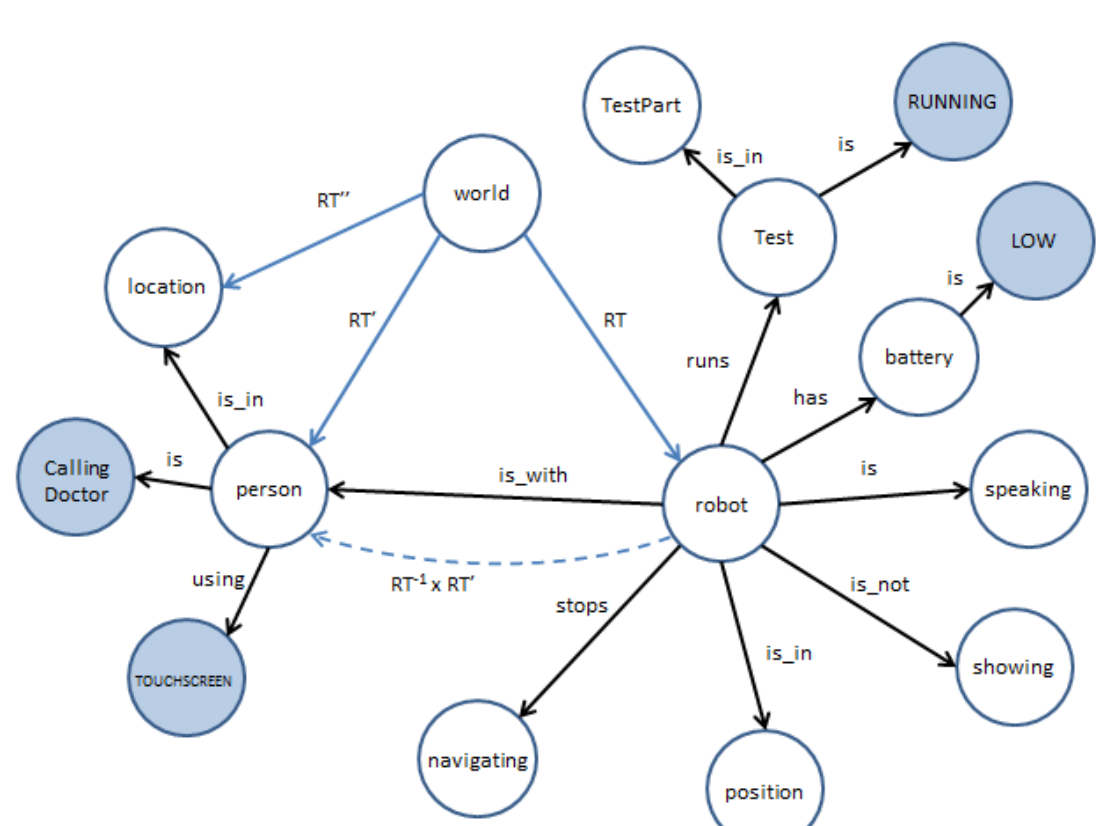
Figure 6. Unified representation of the Deep State Representation (DSR) as a multi-labeled directed graph. For instance, edges labeled as is_with or is_not denote logic predicates between nodes. On the other hand, edges starting at world and ending at person and robot are geometric and they encodes a rigid transformation ( RT (cid:48) and RT respectively) between them. Geometric transformations can be chained or inverted to compute changes in coordinate systems (see